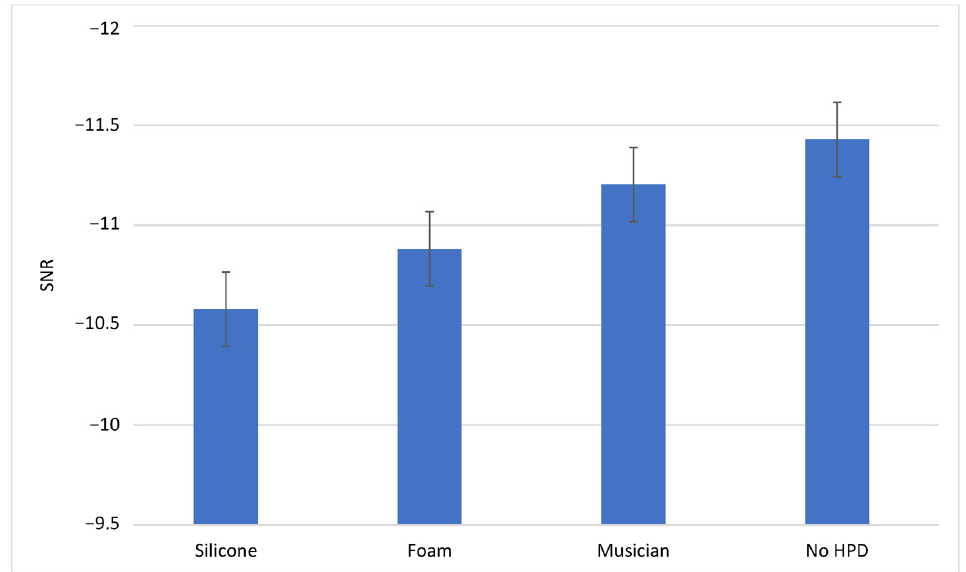
Figure 4. Signal-to-noise ratio in sentence recognition with and without HPD. Legend—HPD: hearing protection device; SNR: signal-to-noise ratio.